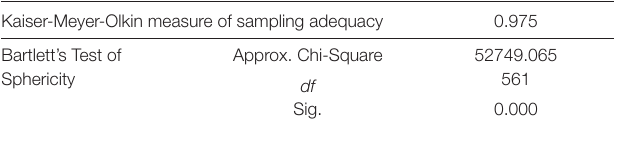
TABLE 2 | KMO and Bartlett’s